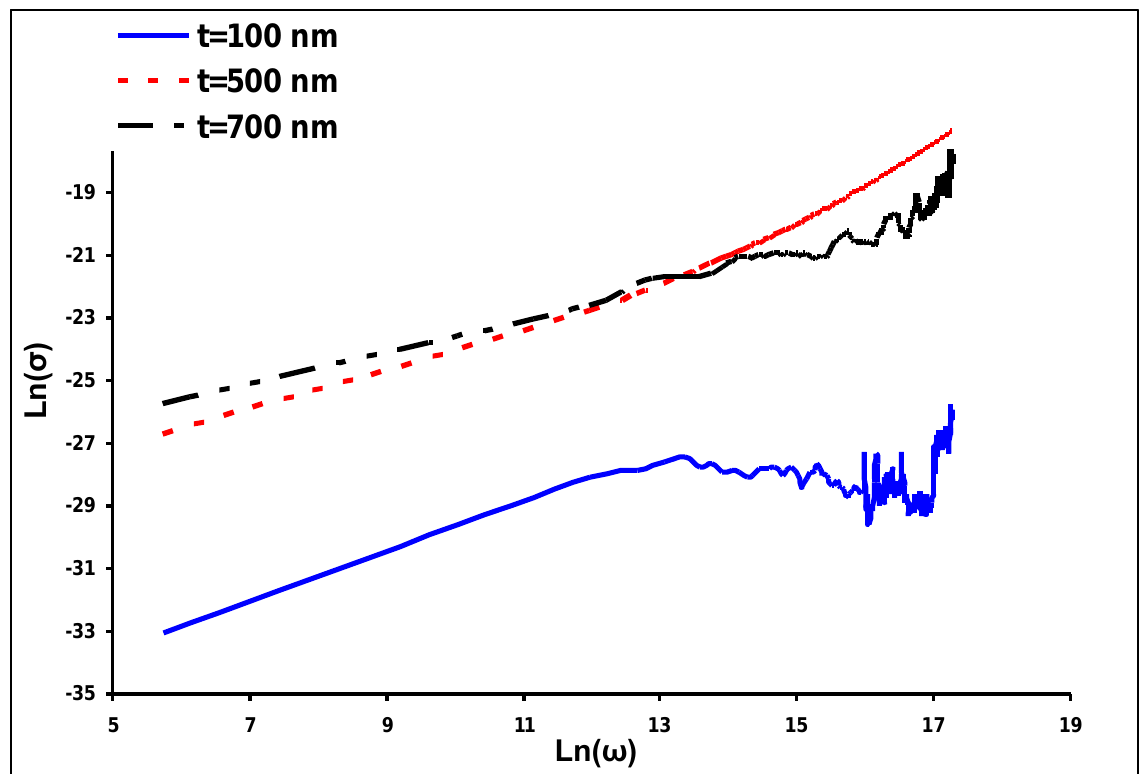
Fig. 3: Variation of Ln σ